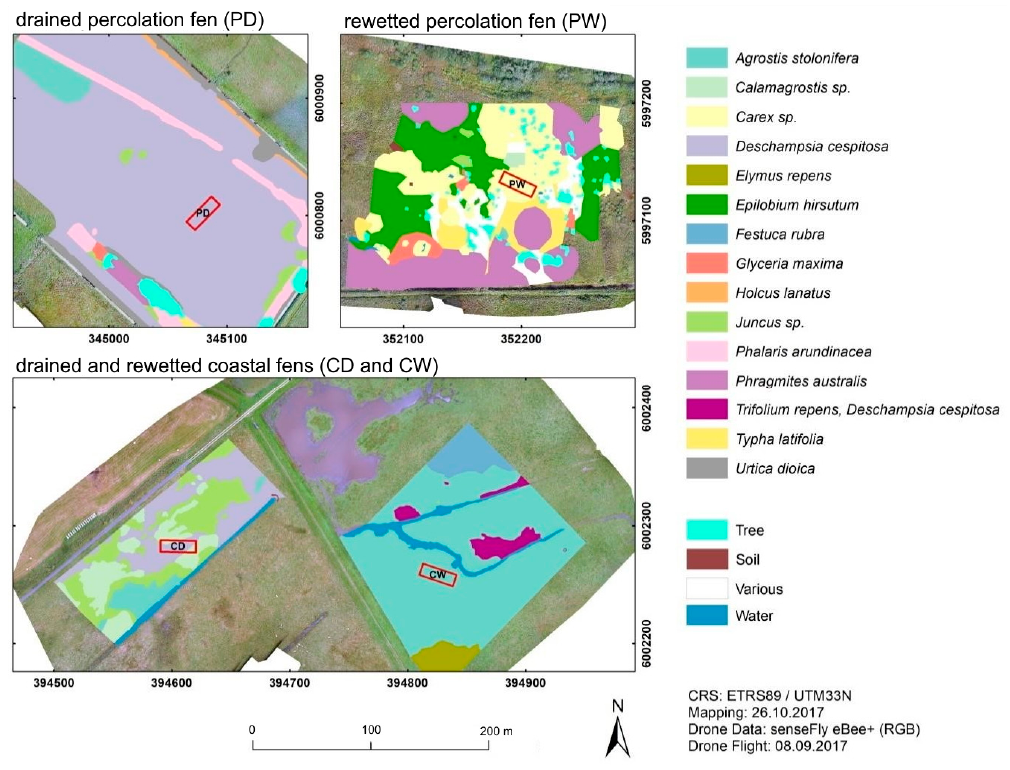
Figure 6. Composition of dominant plant species surrounding the study sites in the drained percolation fen (PD), the rewetted percolation fen (PW) and the drained (CD) and rewetted (CW) coastal fen. The location of the study areas is indicated by red rectangles. The maps result from a survey of the study sites in October 2017 for stands dominated by vascular plants. These were then mapped using aerial photographs. Maps of vegetation structure are not available for the Alder sites, since aerial imagery is difficult to obtain below the tree canopies and mainly Alder would be visible from above.